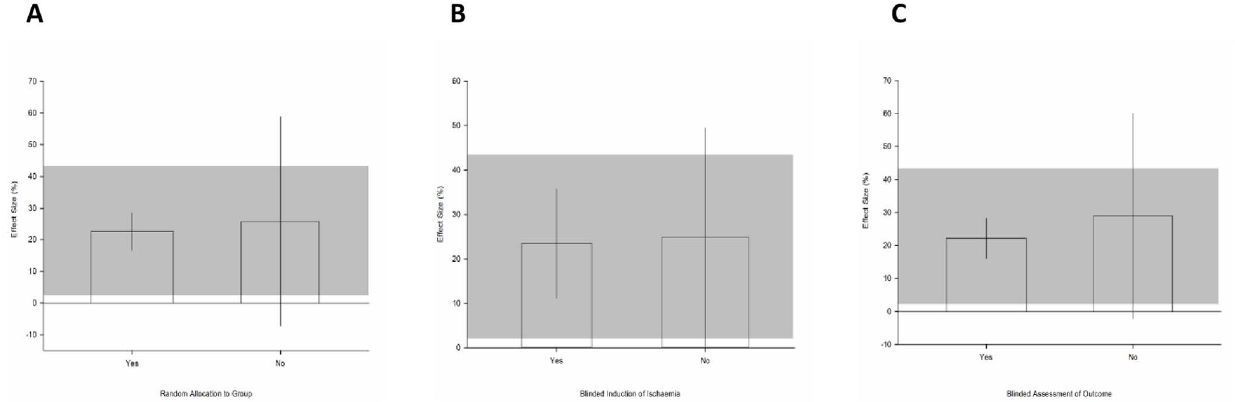
Figure 3. Risk of bias within included studies. Effect of ( A ) random allocation to treatment groups, ( B ) blinded induction of ischaemia and, ( C ) blinded assessment of outcome on improvement in neurobiological score. The shaded gray bar represents the 95% confidence limits of the global estimate. The vertical error bars represent the 95% confidence intervals for the individual estimates. The width of each bar reflects the log of the number of animals contributing to that comparison.